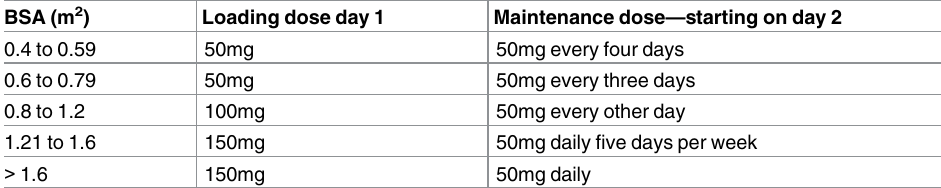
Table 1. Perifosine dose level 1 (~25 mg/m 2 /day).